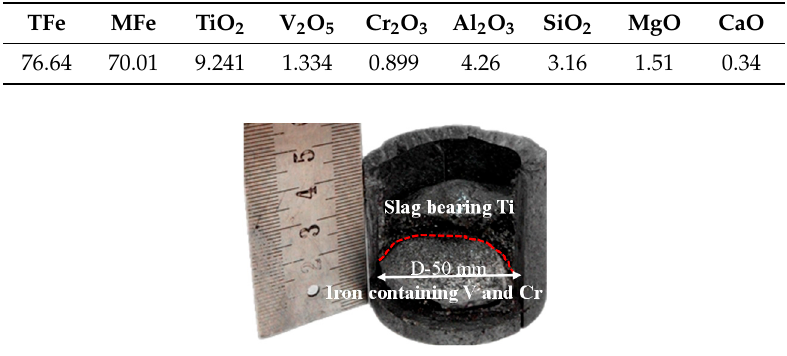
Figure 18. Patterns of melting separation products.